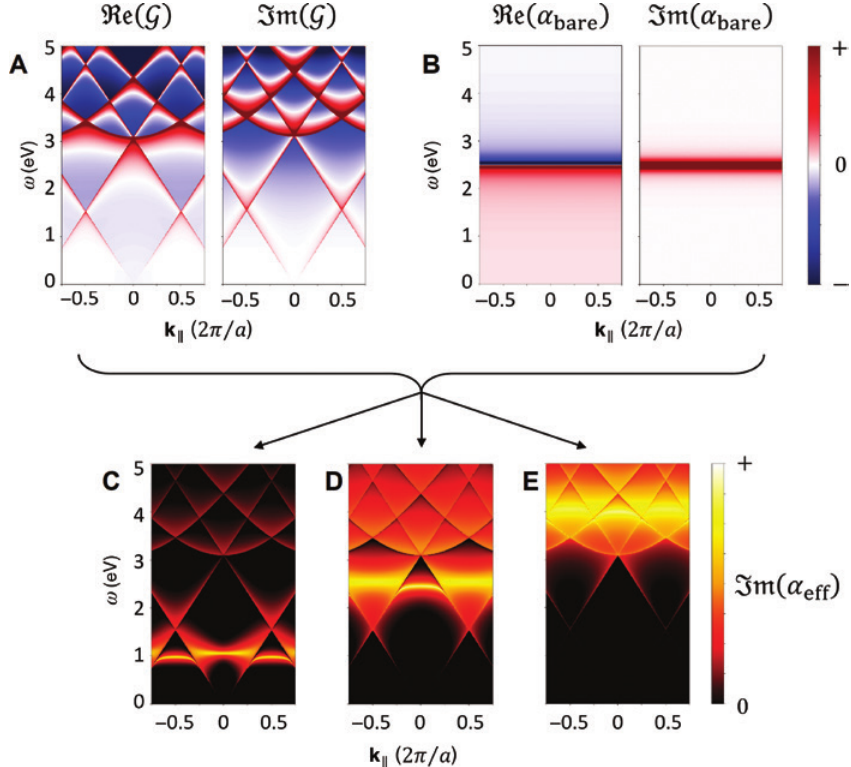
Figure 5: Illustration of an interplay between the terms of Eq. (5) over the parameter space spanned by in-plane momentum (horizontal axis) and frequency (vertical